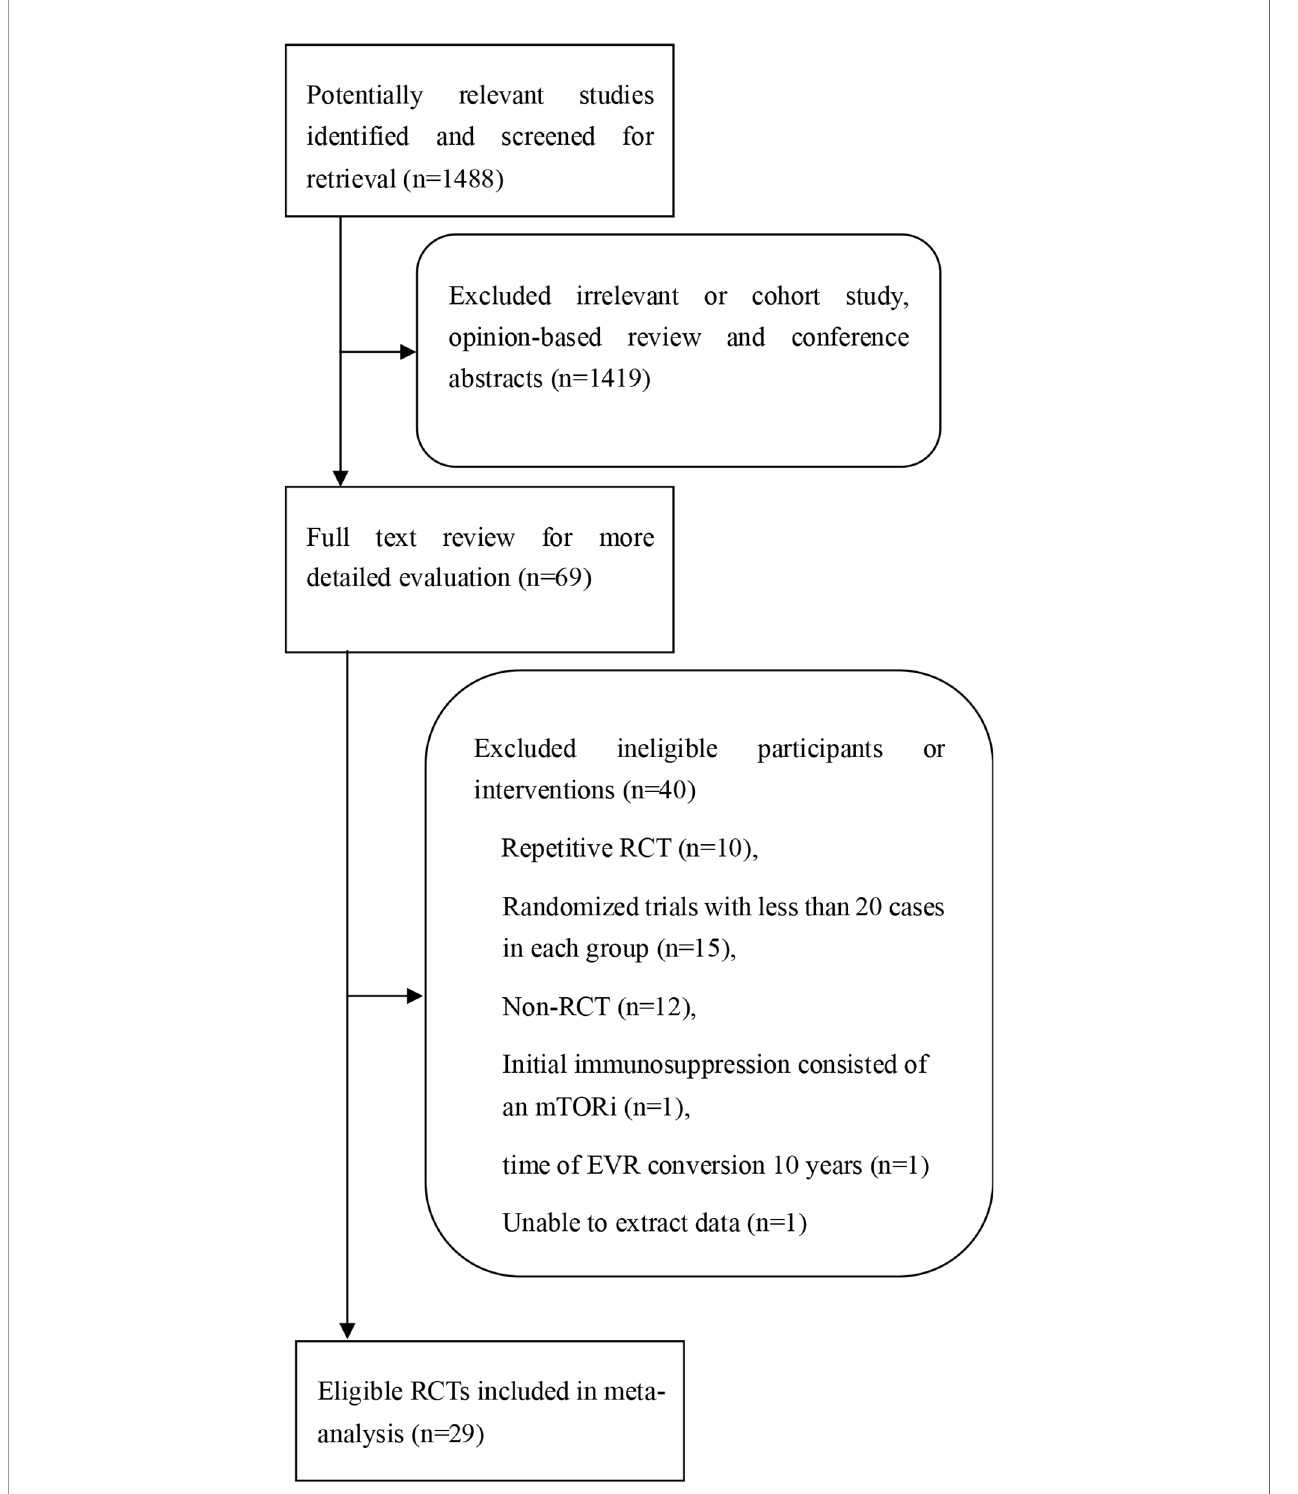
FIGURE 1 | Procedure for the search and selection of RCTs included in the systematic review and